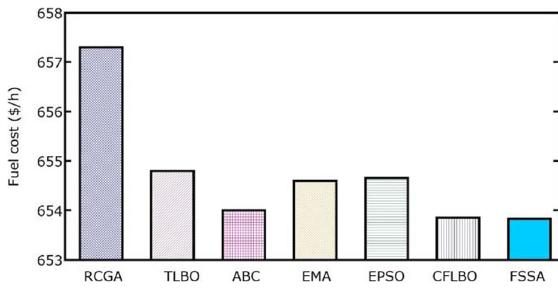
Fig. 8 Comparison of generation costs incurred by various approaches for